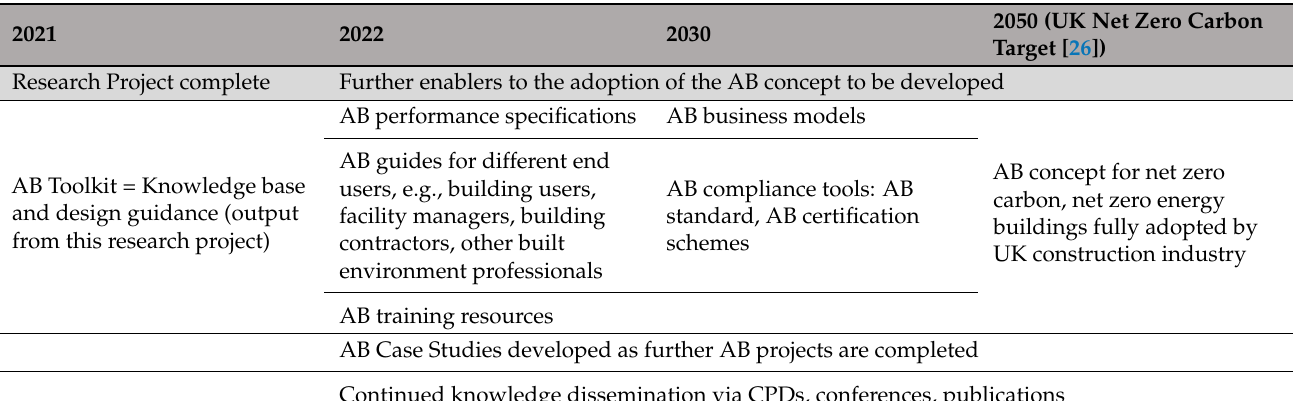
Table 7. Roadmap of Enablers to the Adoption of the AB concept in UK construction projects